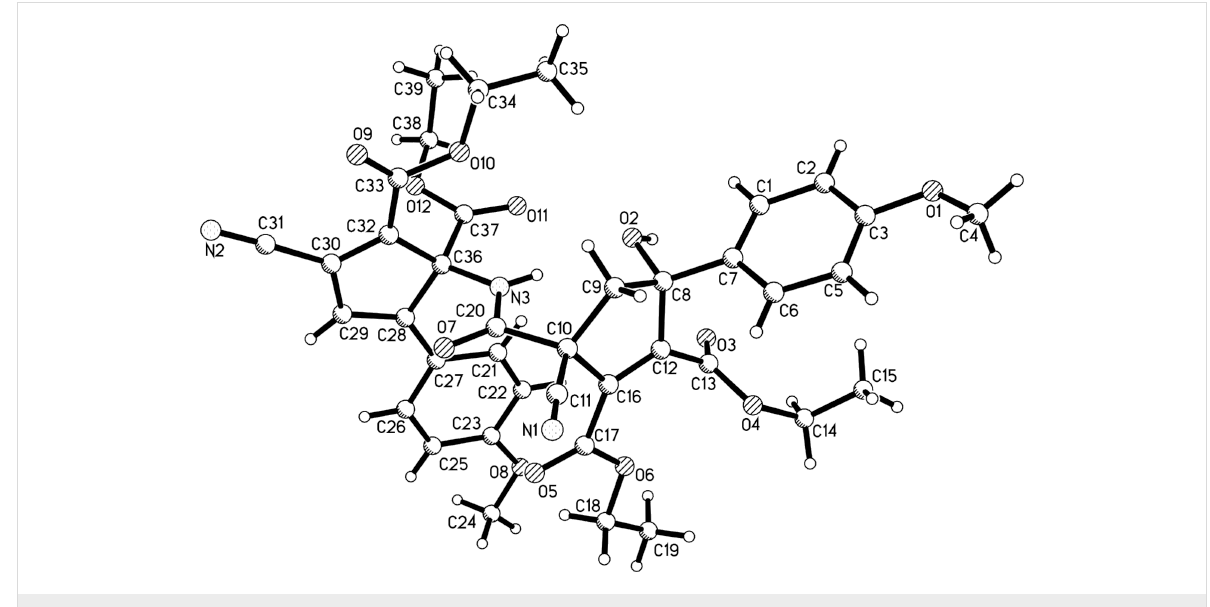
Figure 2: Single crystal structure of compound 4a .